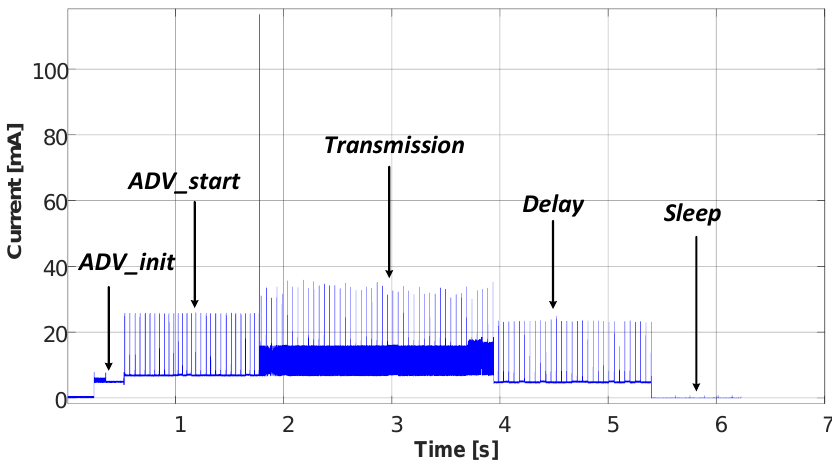
Sensors 2023 , 23 , x FOR PEER REVIEW Figure 5. Experimental current versus time profile of the communications cycle.